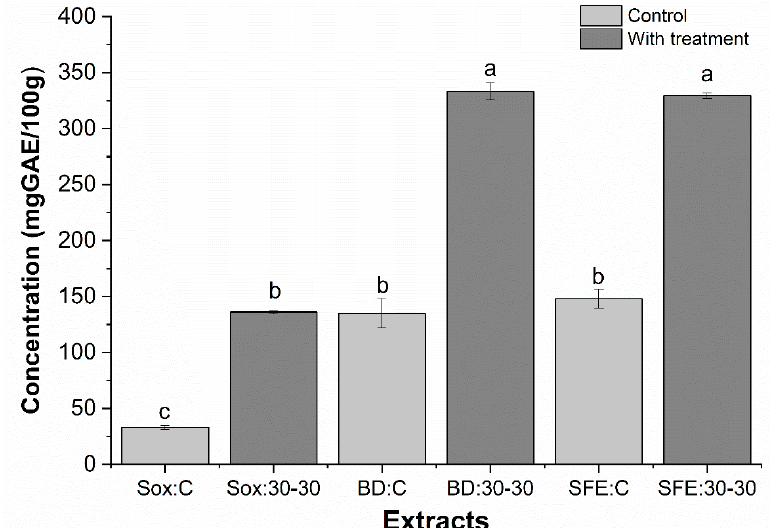
Figure 6. Determination of the total phenolic content of grape oils obtained by low pressure (Sox and BD) and supercritical extraction (SFE) methods, with pretreatment (30:30) and control sample (C). The bars in each column represent the standard error. Samples with the same letter showed no significant difference (p > 0.05) by the Tukey test with 95% confidence.